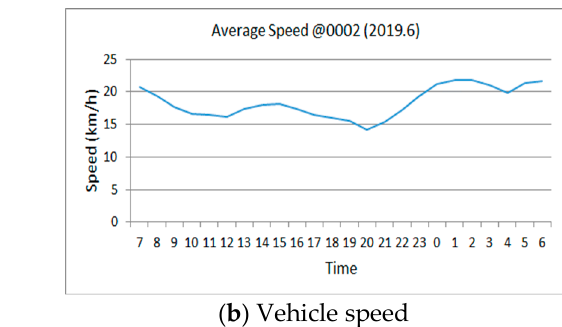
Figure 6. Example of daily traffic flow characteristics at CCTV No. 2.